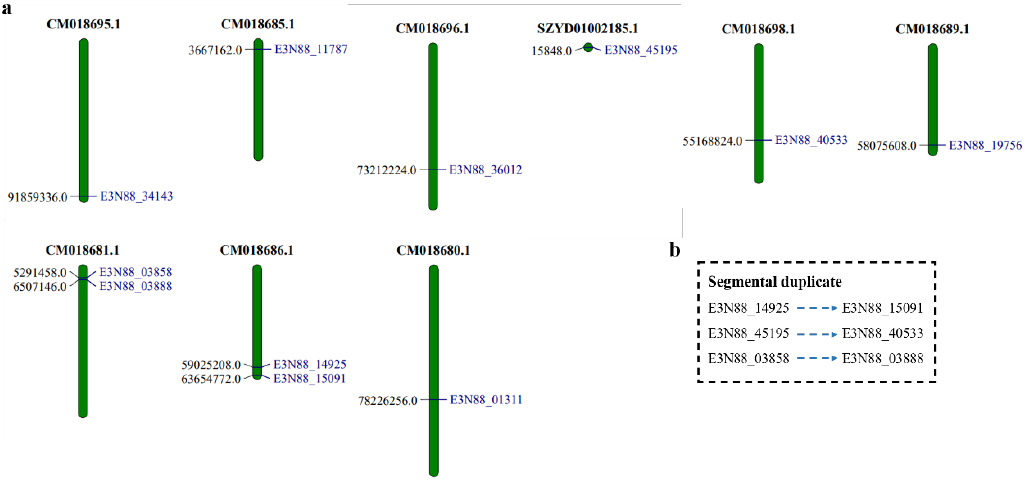
Figure 2. Chromosomal localization of PIN genes in M. micrantha . ( a ) The genome visualization tool MapChart was employed to analyze the M. micrantha genome. M. micrantha chromosomes were arranged in blocks. The 11 PIN genes were mapped by locus. ( b ) Three pairs of segmental duplicated genes E3N88_14925/E3N88_15091, E3N88_45195/E3N88_40533, E3N88_03858/E3N88_03888 are shown with dotted arrows.